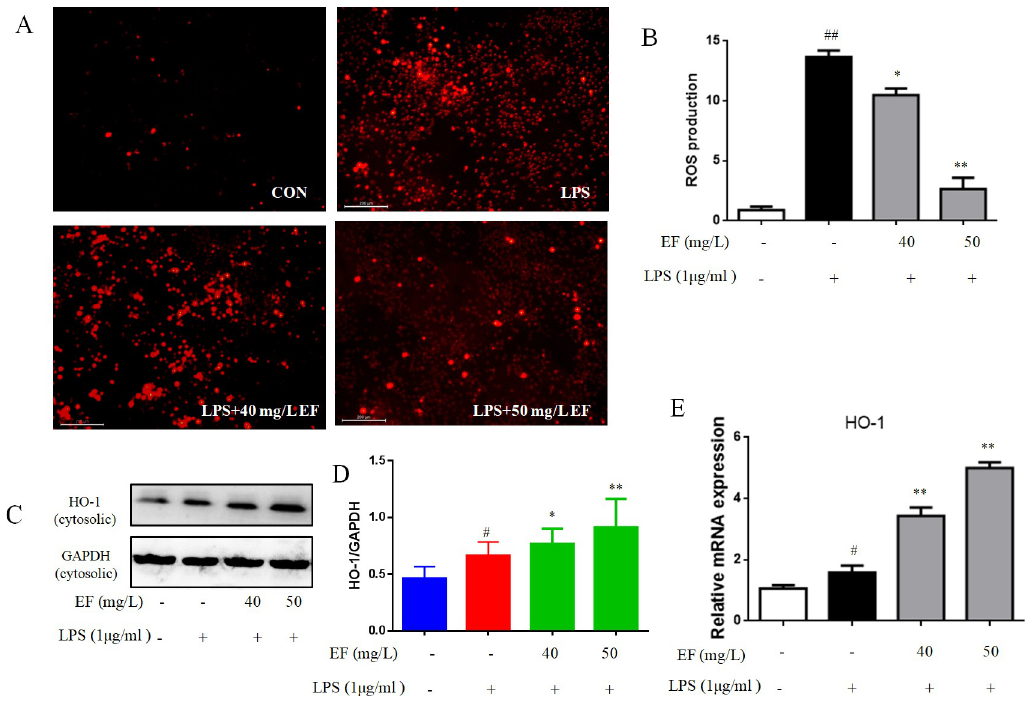
Fig 5. EF protected macrophages from oxidative stress. A/B: after stimulation, intracellular ROS levels were measured by DCFH-DA. C/D/E: The mRNA and protein levels of HO-1 were determined by Western blotting analysis using specific antibodies. All data are shown as mean ± SEM (n = 6, per group) #P < 0.05, ##P < 0.01 vs control; � P < 0.05, �� P < 0.01 vs LPS.